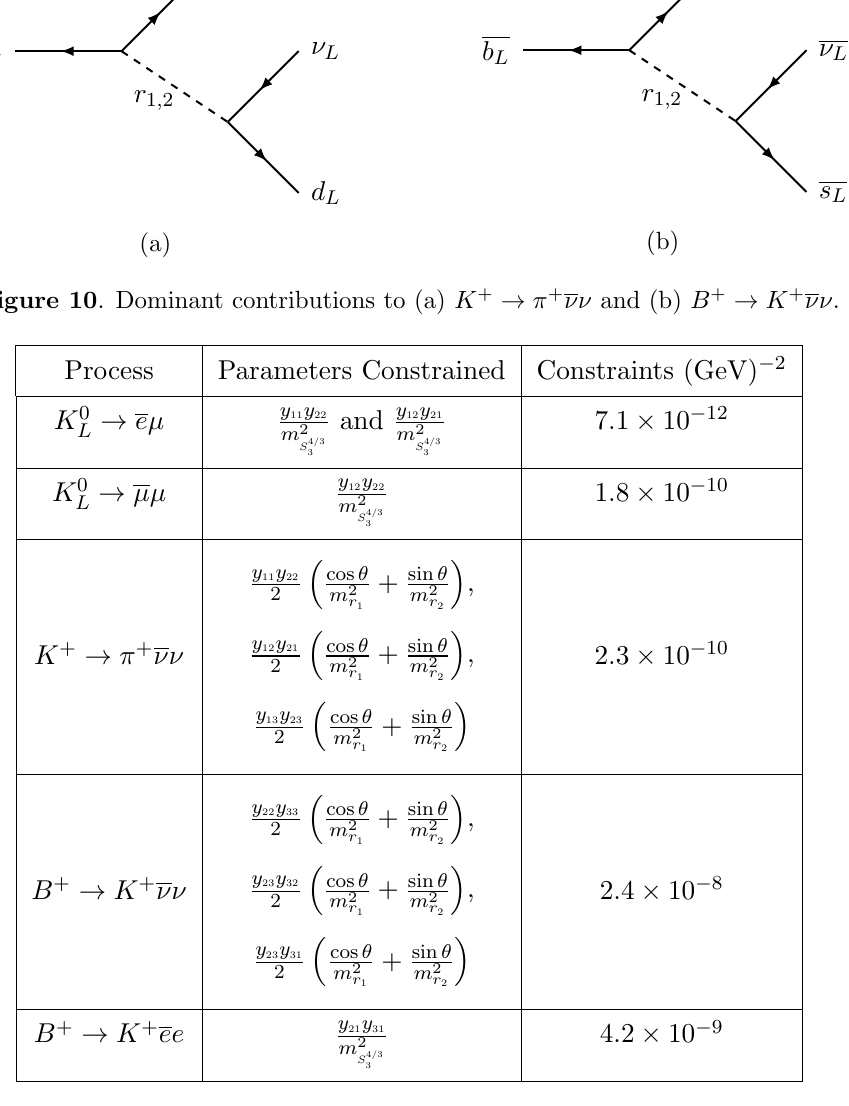
Table 4 . Constraints applied to expression involving leptoquark couplings and masses, derived from leptonic and semi-leptonic rare meson